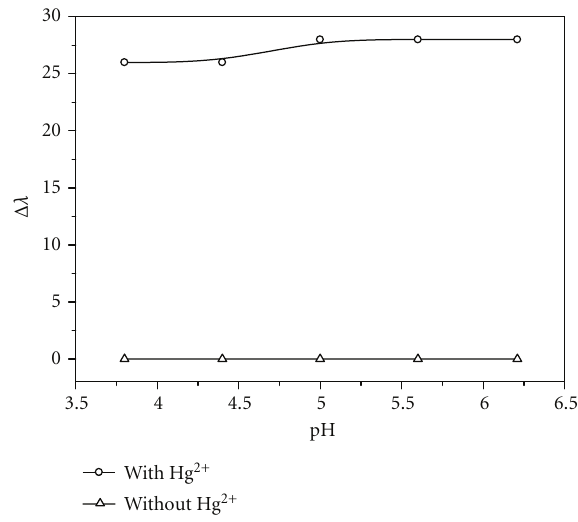
Figure 3: The influence of acidity. Concentration: AgNPs: 5.0 × 10 − 5 mol/L − 1 ; Hg (II) ion: 6.0 × 10 − 6 mol/L; the pH of HAc-NaAc bu ff er (from 1 to 5): 3.8, 4.4, 5.0, 5.6, 6.2.